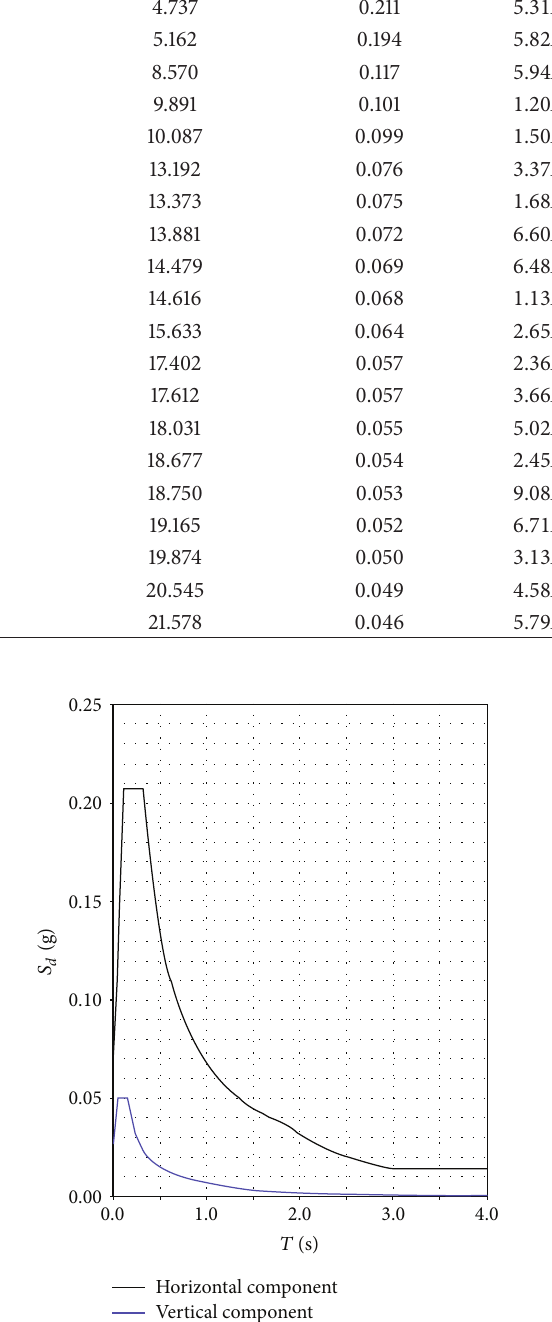
characteristics, a nominal life of the structure equal to 400 years, and a probability to exceed the acceleration spectrum equal to 5% in 400 years. The structural damping of